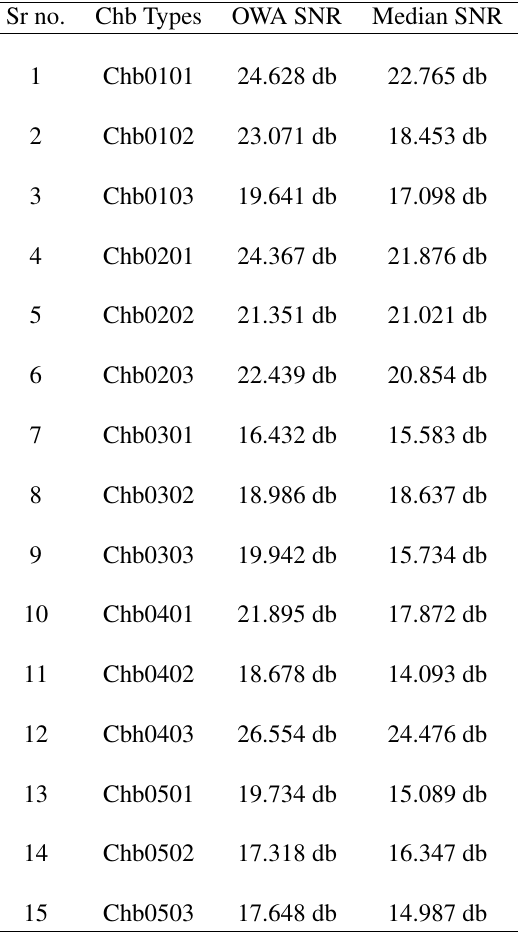
Table 2. Signal to Noise Ratio